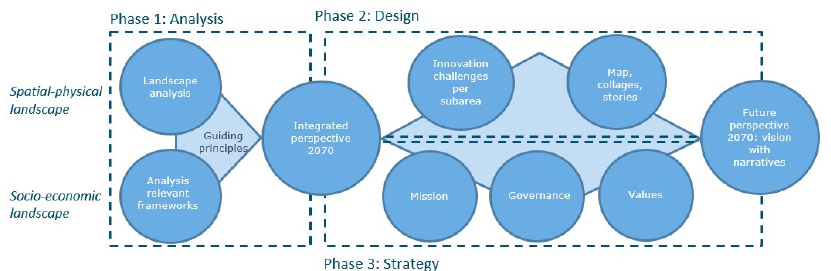
Figure 5. Setup of the visioning process of the Coastal Zone Holland case.